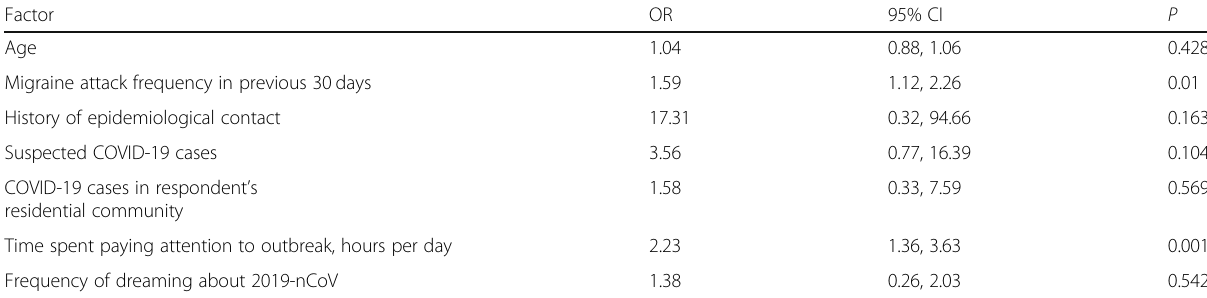
Table 4 Multivariate logistic regression to identify independent predictors of severe psychological distress (K6 score ≥ 12) Factor